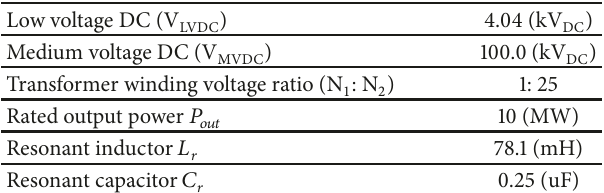
Table 1: Parameters of SRC# plant